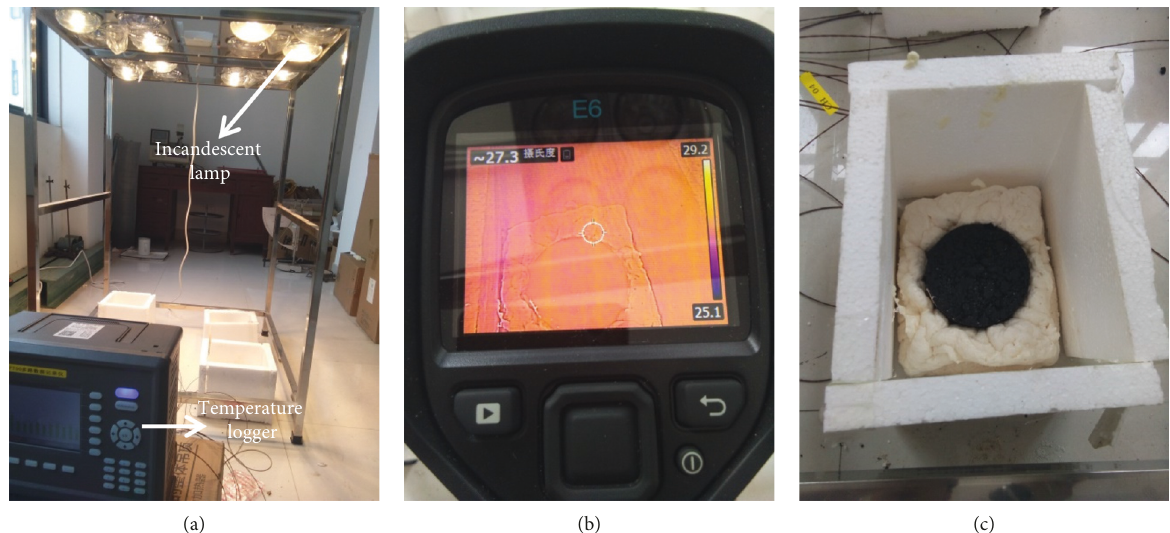
Figure 4: Schematic diagrams of indoor irradiation test: (a) irradiation instrument; (b) infrared imaging instrument; (c) thermally insulated specimen.